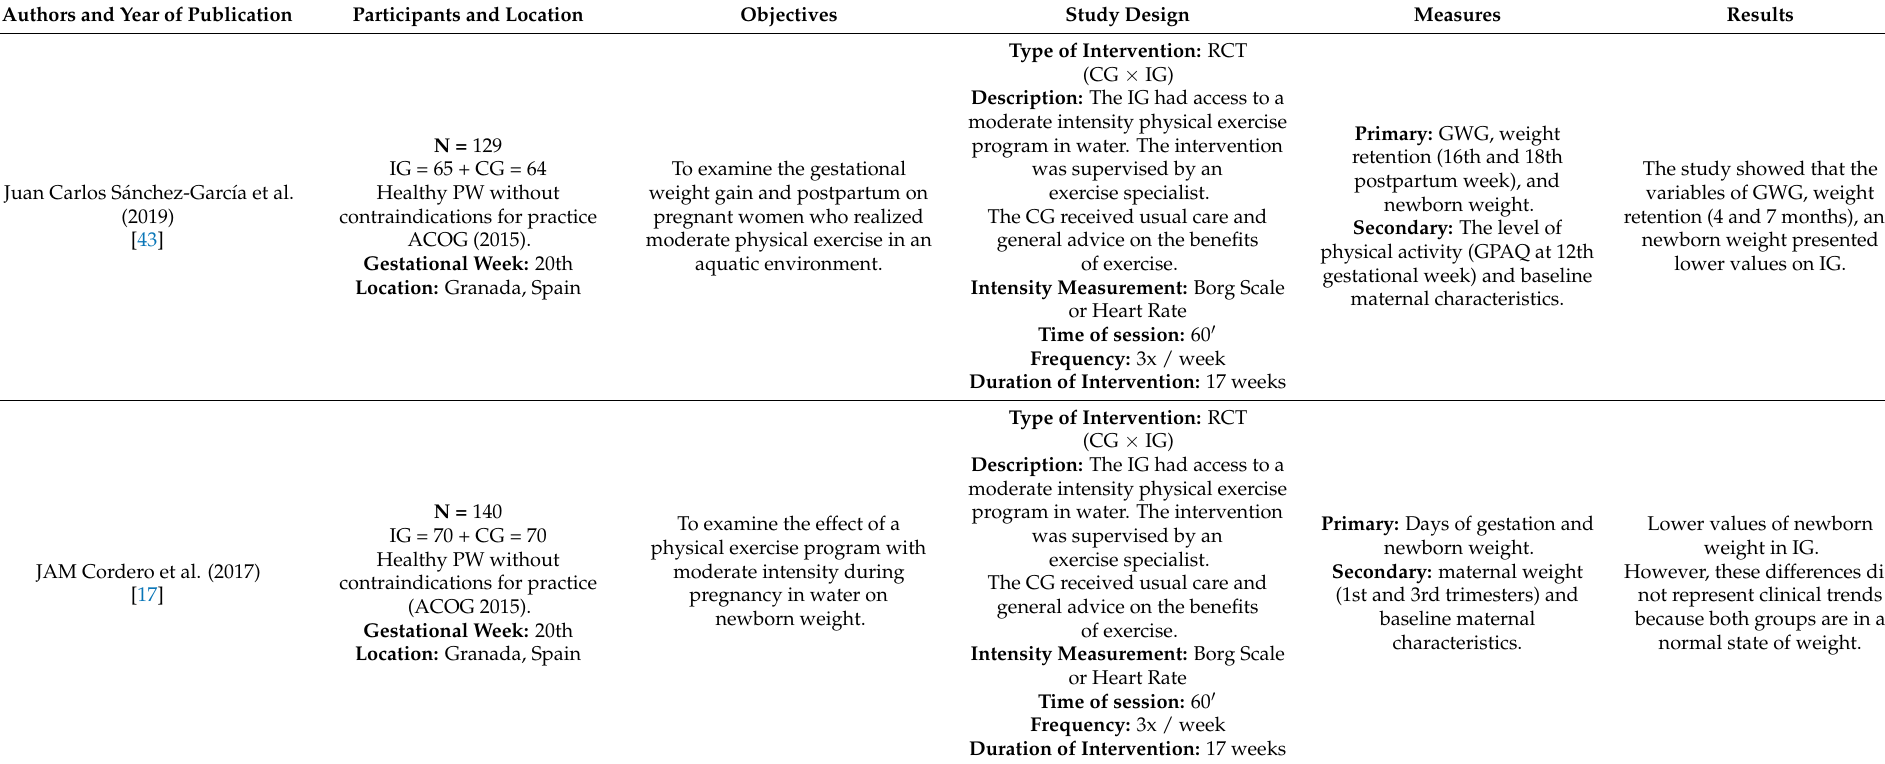
Table 2. Charactheristics of the